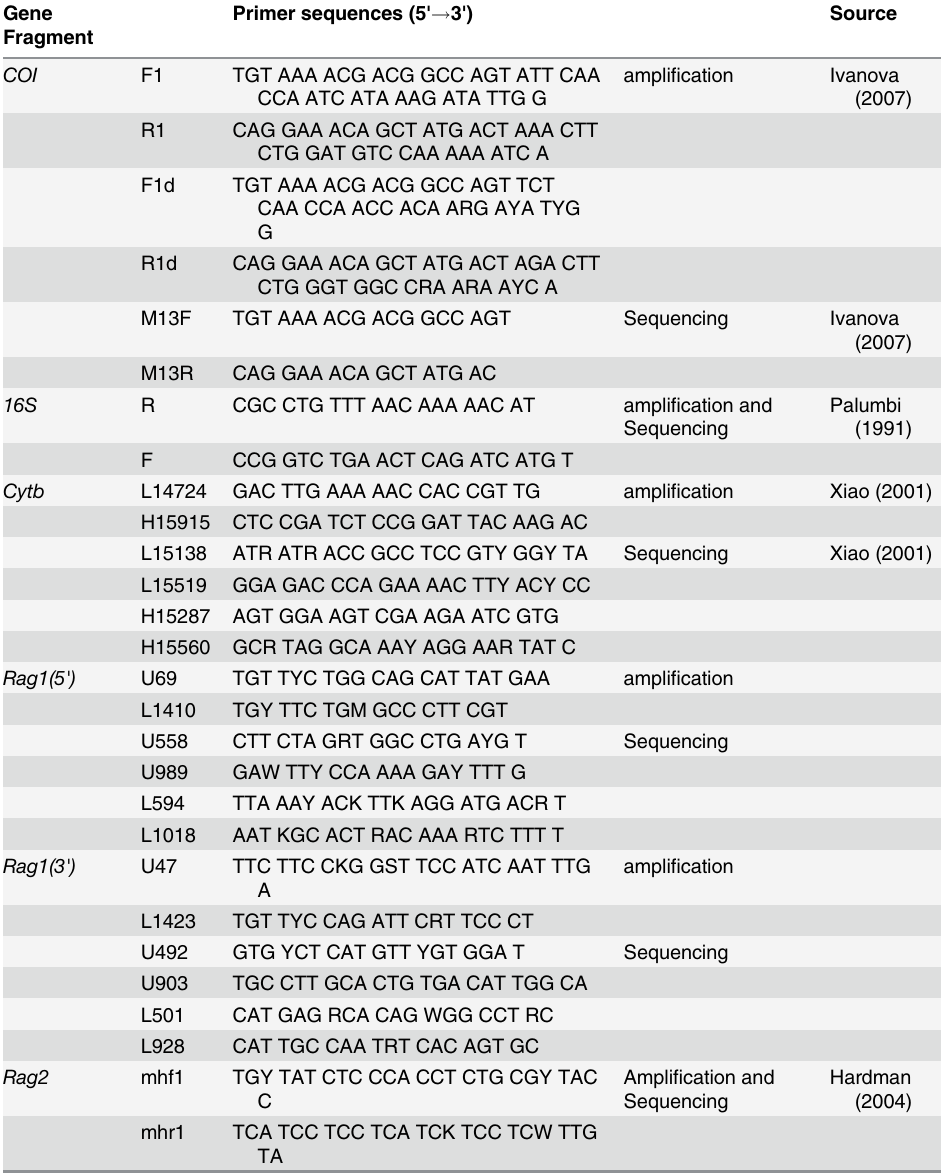
The PCR ampli fi cation primers and sequencing primers of the nuclear genes were designed based on RAG sequences of Pangasiidae in